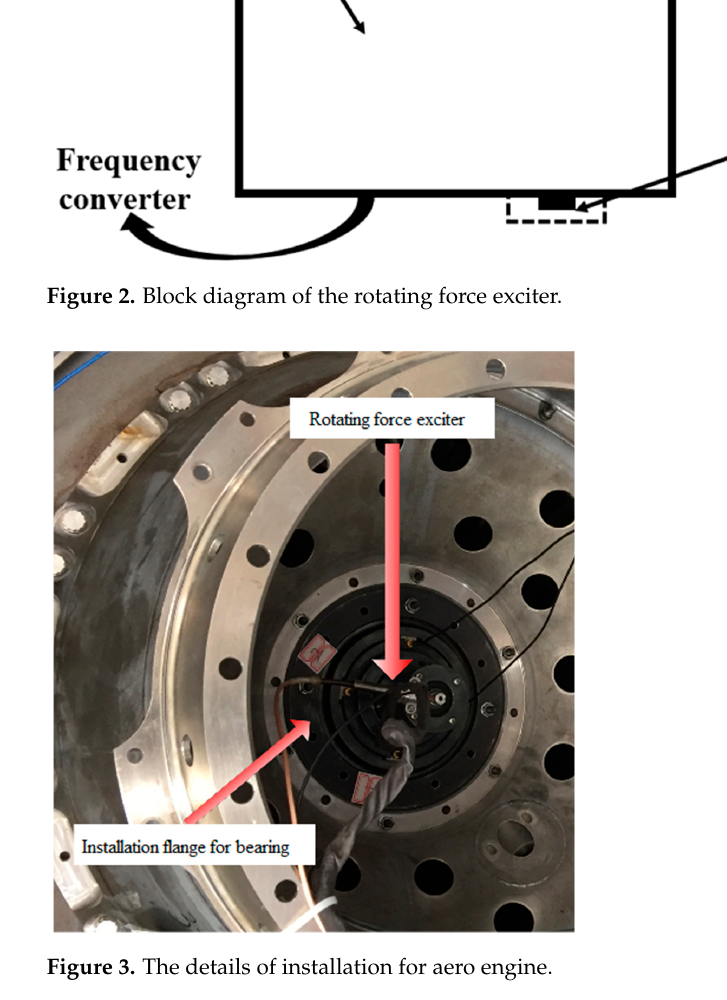
Figure 3. The details of installation for aero engine.